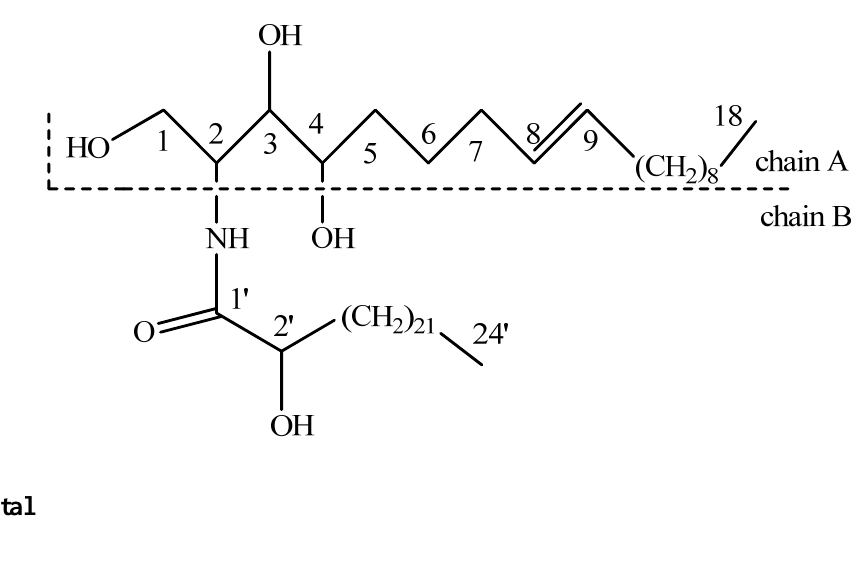
Figure 1. The structure of